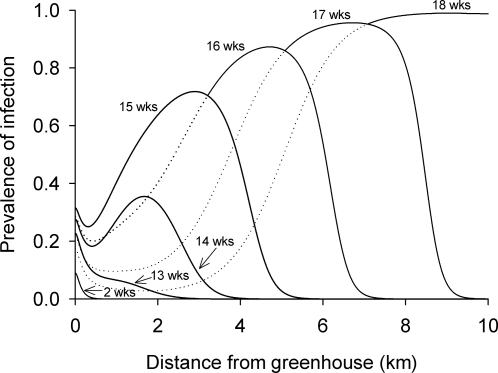
Predicted long-term dynamics of pathogen spillover into wild bumble bee populations near greenhouses.Prevalence curves were generated through numerical simulation of our diffusion model [equations (1)–(3)] using the parameter estimates given in Table 2. This figure illustrates a slow build-up of pathogenic C. bombi in the wild population (t = 2 wks to t = 13 wks; traces for weeks 3–12 omitted for clarity) followed by a large, rapidly forming, wave front of infection (t = 13 wks to t = 18 wks) that travels away from the greenhouse at approximately 2 km per week.